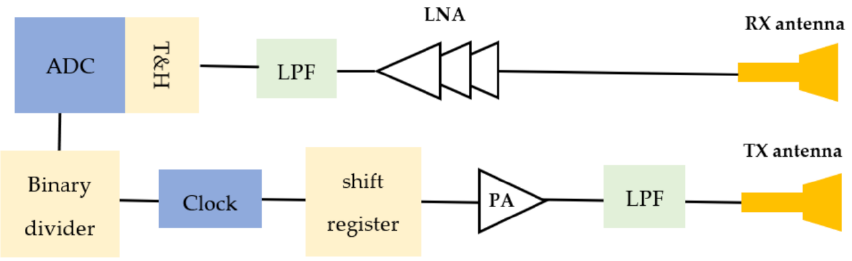
Figure 12. Block diagram of the m-sequence